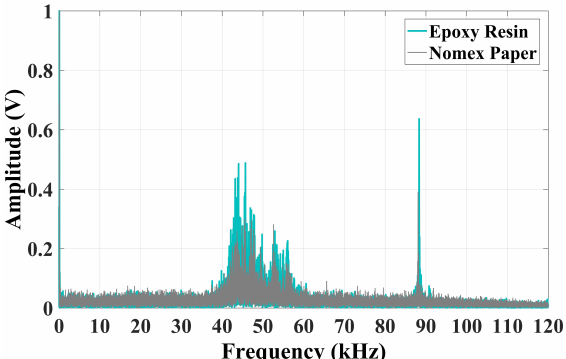
Figure 10. Frequency content of PD activity in epoxy resin and Nomex paper for Hall-effect current sensor. The chromatic technique is presented in Figure 11.